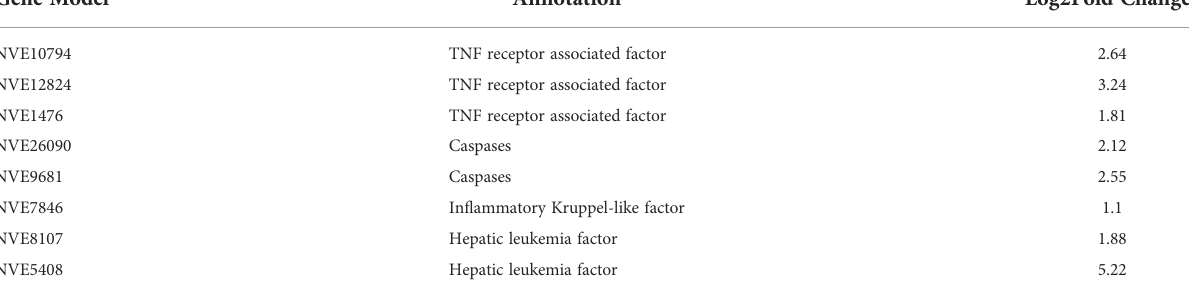
TABLE 1 Eight upregulated genes were identi fi ed in